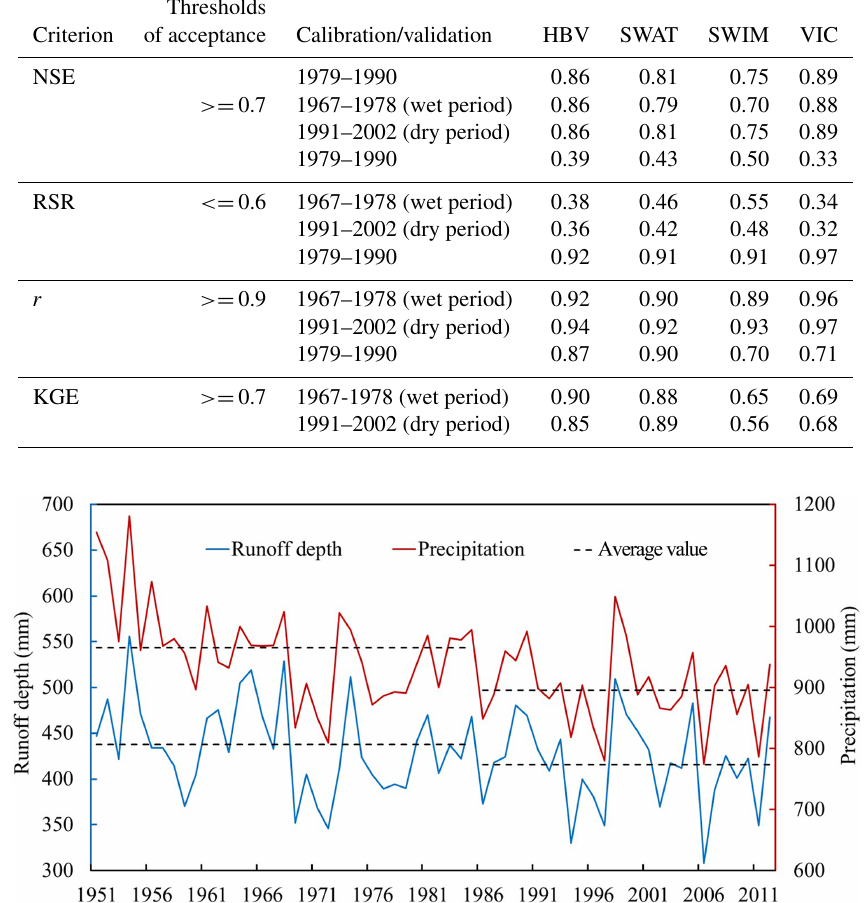
Figure 5. Annual precipitation and runoff depth observed in the upper Yangtze River basin in the period